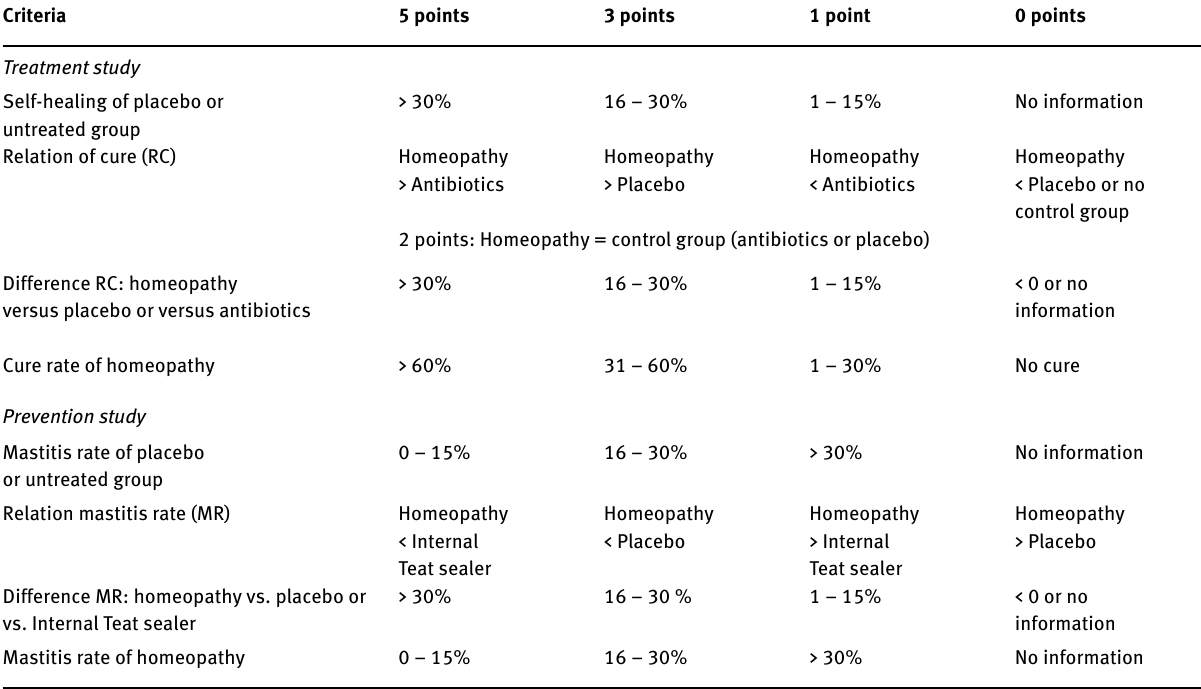
Table 2: Assessment criteria with a rating score of 0 to 5 points: effect of healing and prevention